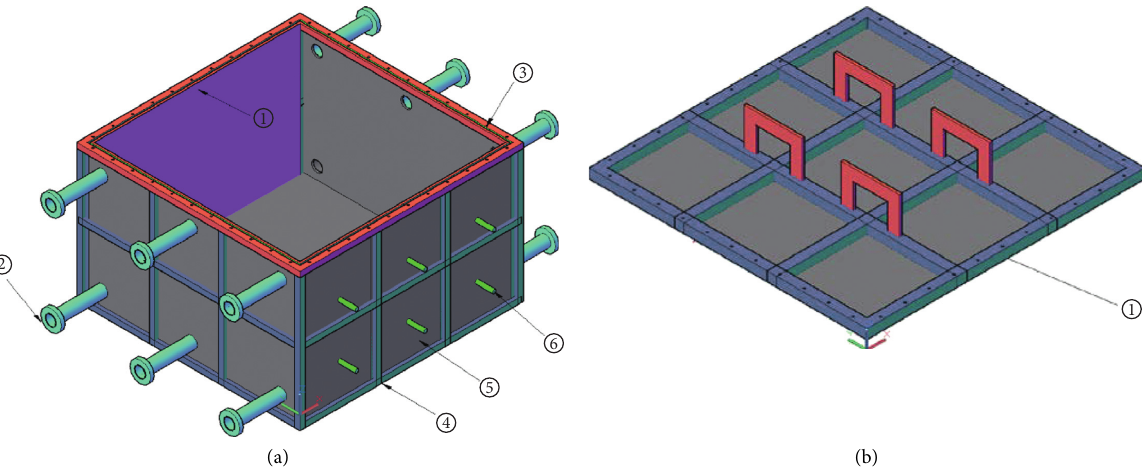
Figure 1: Schematic diagram for the model box: (a) schematic diagram for the lower box and (b) diagram for the upper